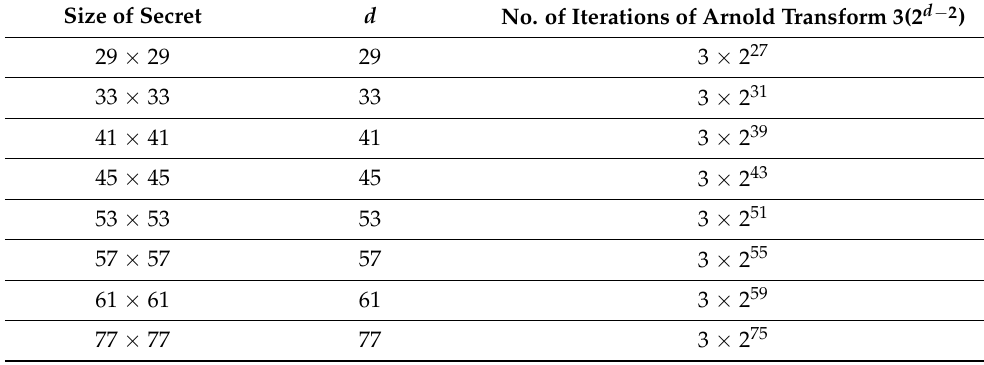
Table 7. Total number of computations to recover the secret.